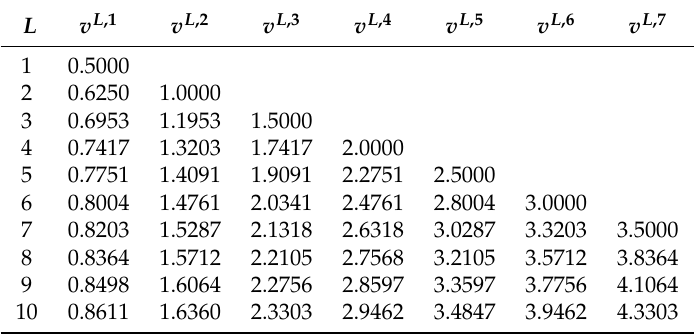
Table 1. The values for the uniform distribution U ( 0,1 )